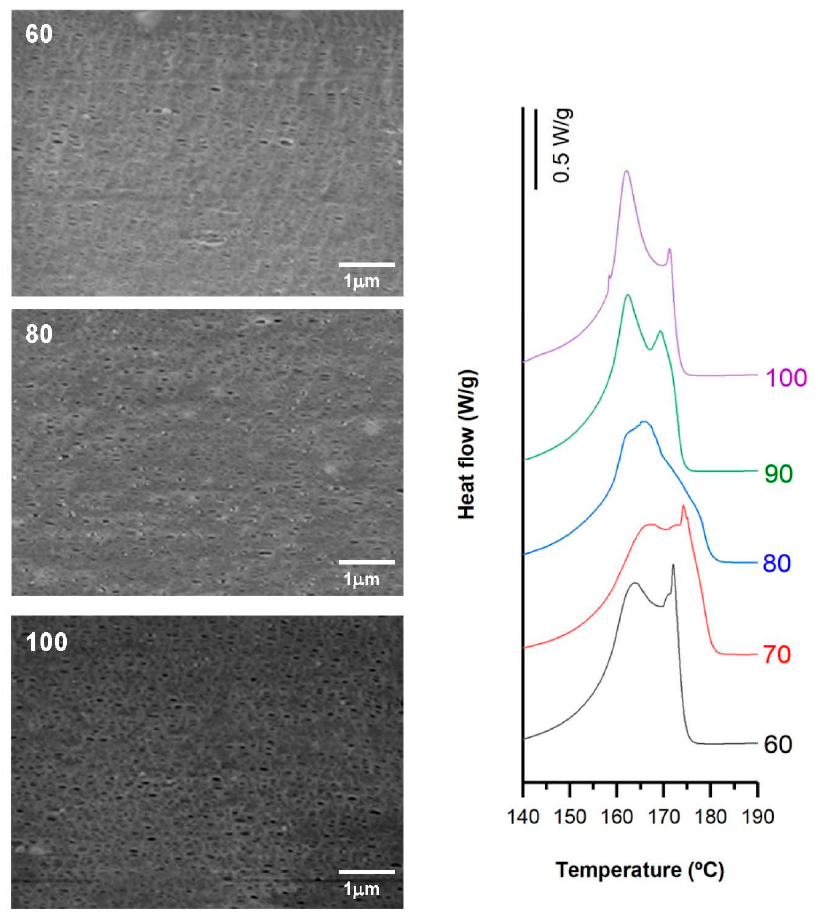
Figure 7. SEM micrographs and thermograms of H1-C10, differing in their draw ratio. Processing conditions: Gap die, 1.9 mm; cold stage 0.3 mm/min, 20%; hot stage 0.3 mm/min, 130%. Table 4. Draw ratio analysis in terms of orientation, crystallinity, pore morphology and